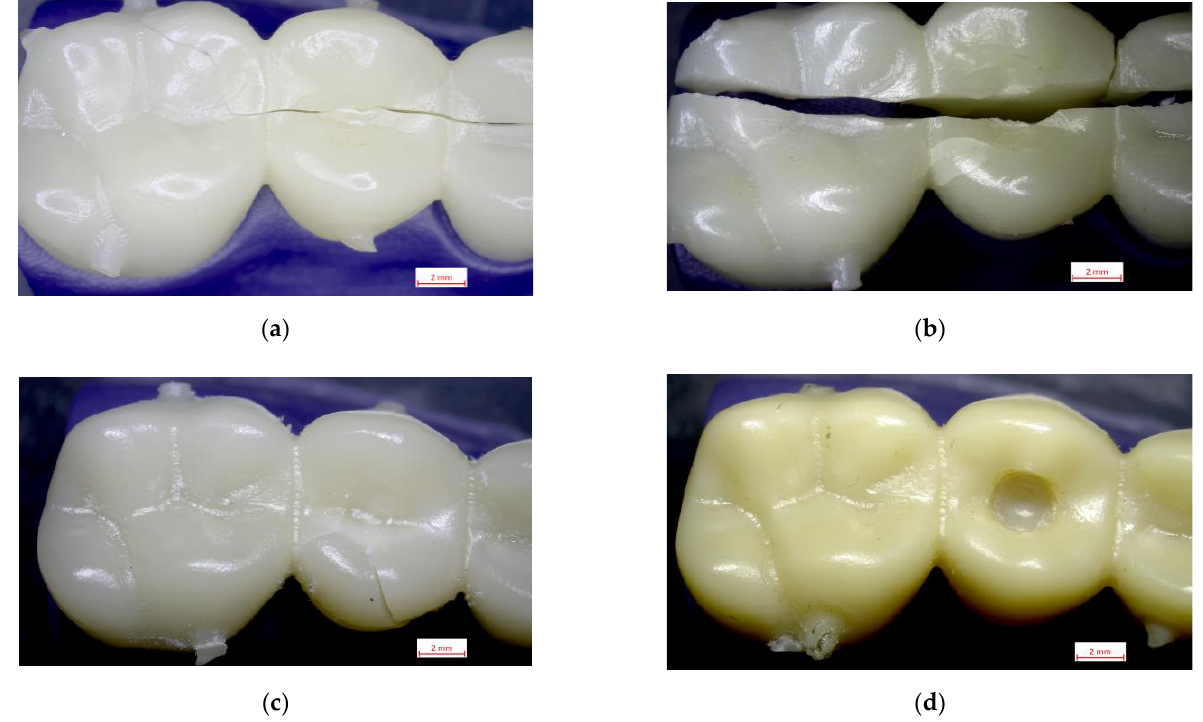
Figure 7. Images of the fracture surfaces of the different materials studied: ( a ) PMMA; ( b ) GRA; ( c ) RA and ( d ) PS. ( c ) RA and ( d )